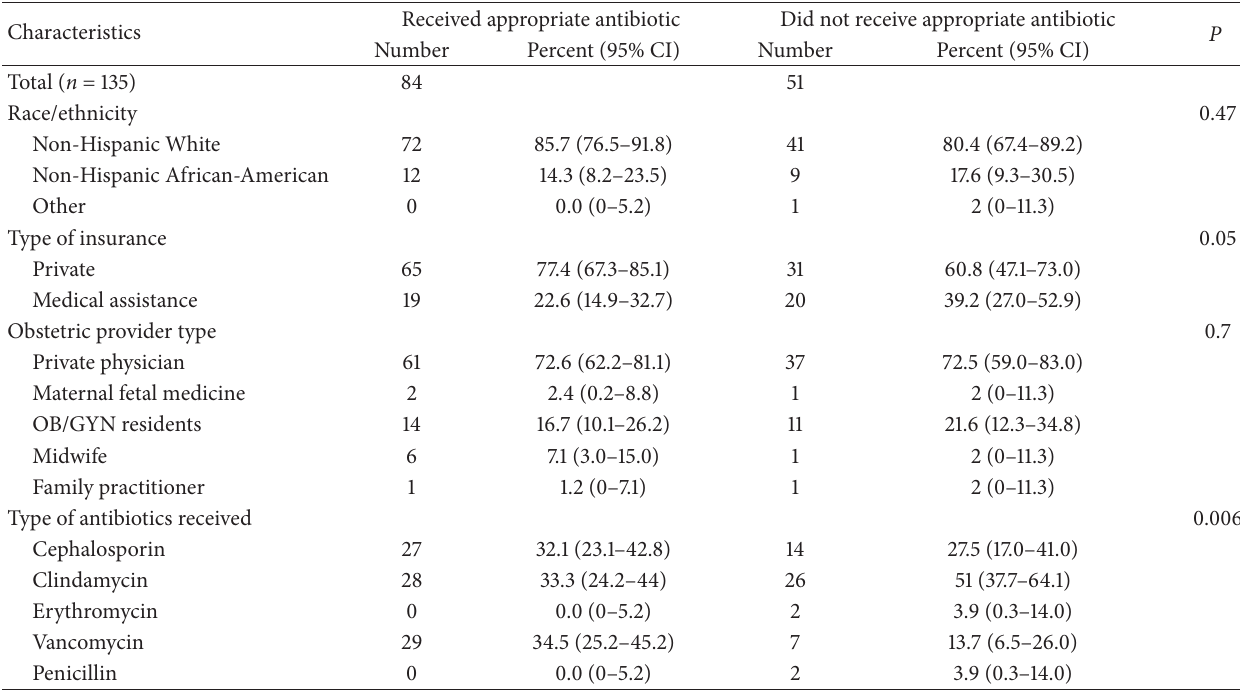
Table 3: GBS+, penicillin-allergic patients who delivered at Magee-Womens Hospital in 2010. Comparisons between women who received appropriate antibiotic ∗ and women who did